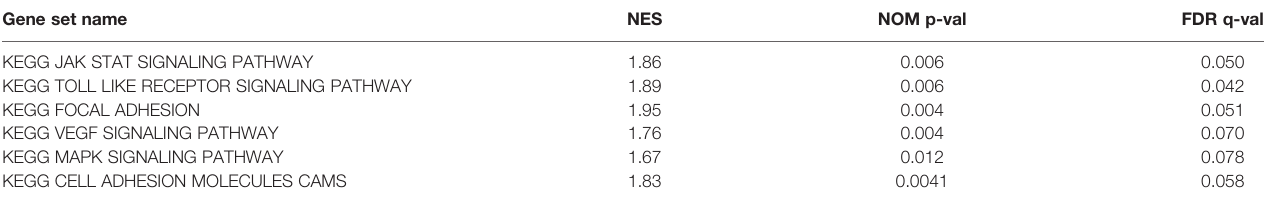
TABLE 1 | The gene set enriches the high GNG12 expression phenotype.